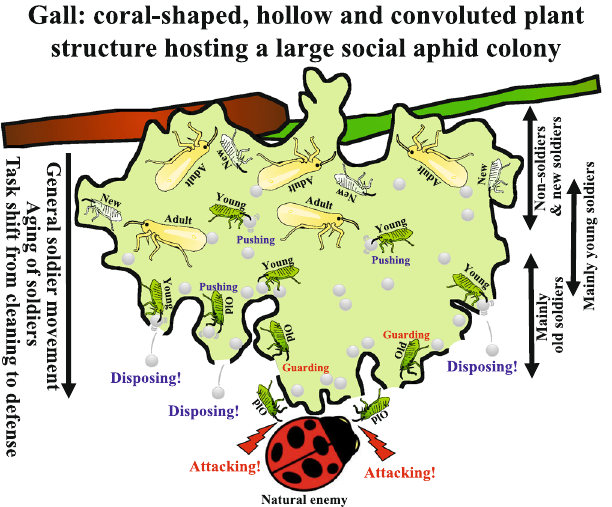
Figure 6. Graphical presentation of age polyethism in natural gall colony of T. styraci , highlighting the relevance of gall structure to production, aging and movement of